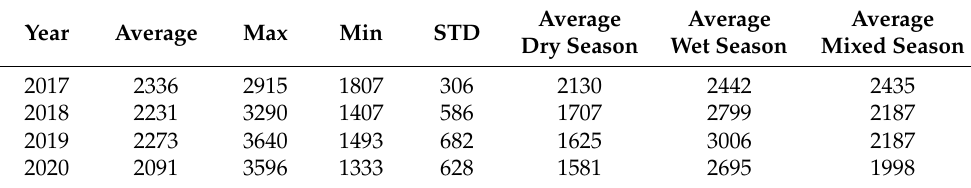
Table 2. Descriptive statistics for the annual and seasonal river plume area (km 2 ) between 2017–2020 in Liverpool Bay, showing the average, maximum (Max), minimum (Min), standard deviation (STD) and the average per season per